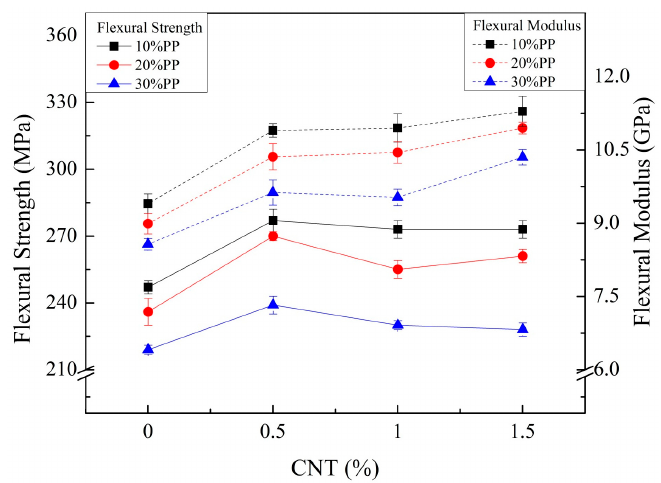
Figure 3. Flexural strength and modulus results of CF- and CNT-reinforced PA6/PP composites with different PP and CNT compositions.